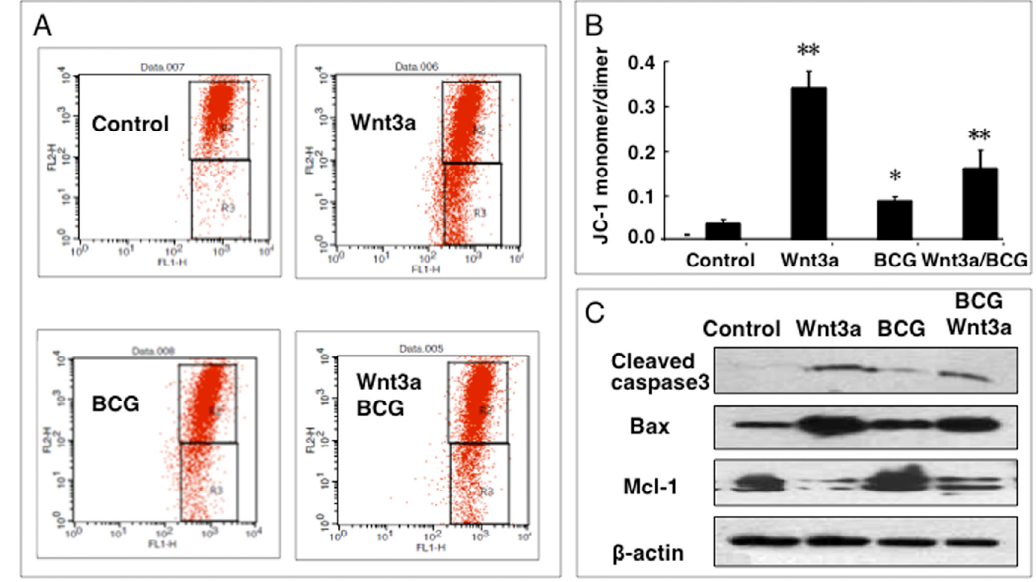
Figure 4. Impact of Wnt/ β -catenin signaling on mitochondrial membrane potential ( ∆Ψ m) of RAW264.7 cells. ( A ) Representatives of dot plot of flow cytometry analysis for ∆Ψ m of cells treated with indicated condition for 12 h; ( B ) fractions of cells with low ∆Ψ m treated with indicated conditions for 12 h; ( C ) Immunoblots of apoptosis-related proteins in RAW264.7 cells treated with indicated conditions for 24 h. Compared to a naïve control, * p < 0.05; ** p < 0.01. Data represented the mean ± SD from three independent duplicate experiments ( n =